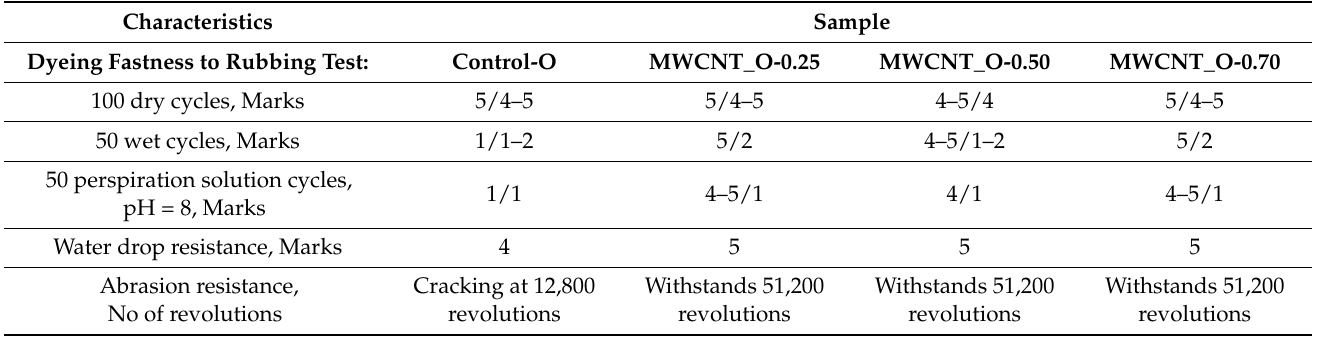
Table 6. Physical–mechanical resistance of the sheepskin leather surface treated with MWCNTs.